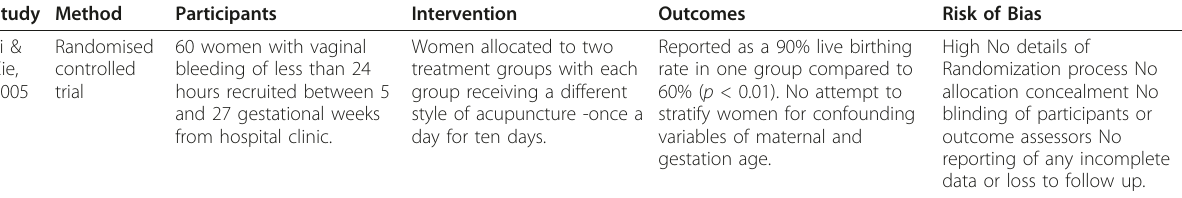
Table 2 A Randomised Controlled Trial of Acupuncture use in Threatened Miscarriage Study Method Participants